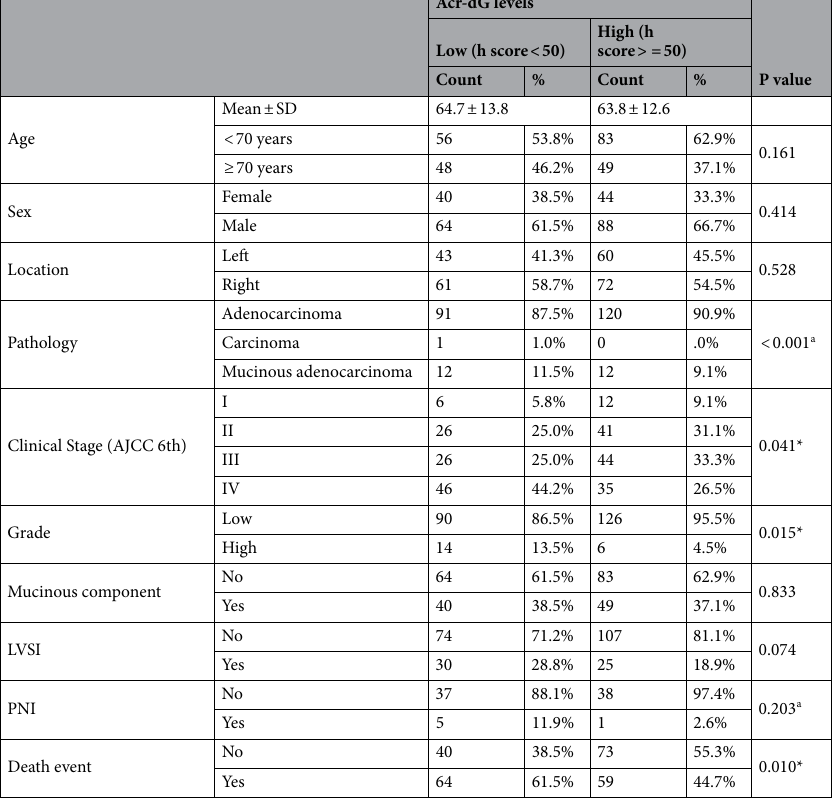
Table 1. Clinical characteristics of CRC patients. AJCC American Joint Committee on Cancer, LVSI lymph- vascular space invasion, PNI perineural invasion. *P < 0.05, the chi-square statistic is significant at the 0.05 level. a Fisher’s exact